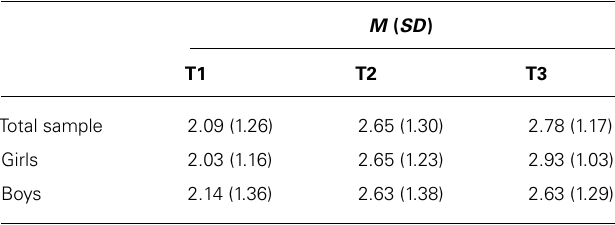
Table 6 | Means and standard deviations of aggregated